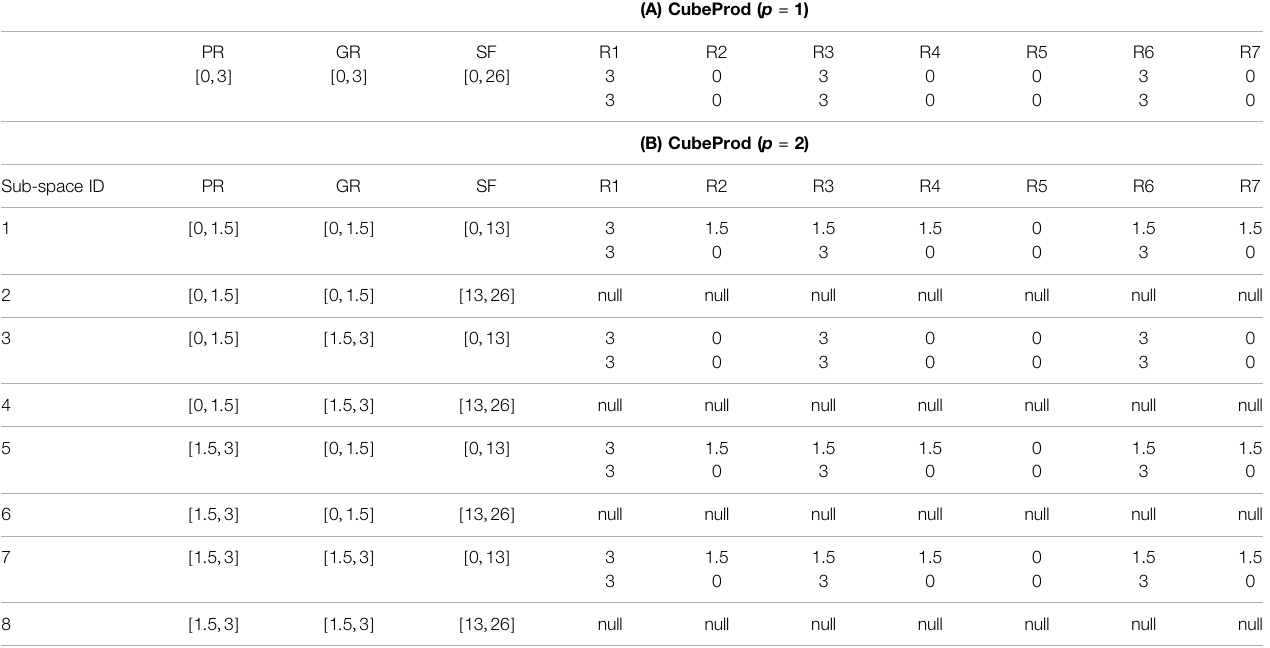
TABLE 1 | DynCubeProd applies CubeProd beginning with p (cid:2) 1 and increments one by one and quits when a desired reaction deletion strategy is obtained. (A) and (B) represent the results of DynCubeProd applied to the network of Figure 2A with p (cid:2) 1 and p (cid:2) 2,